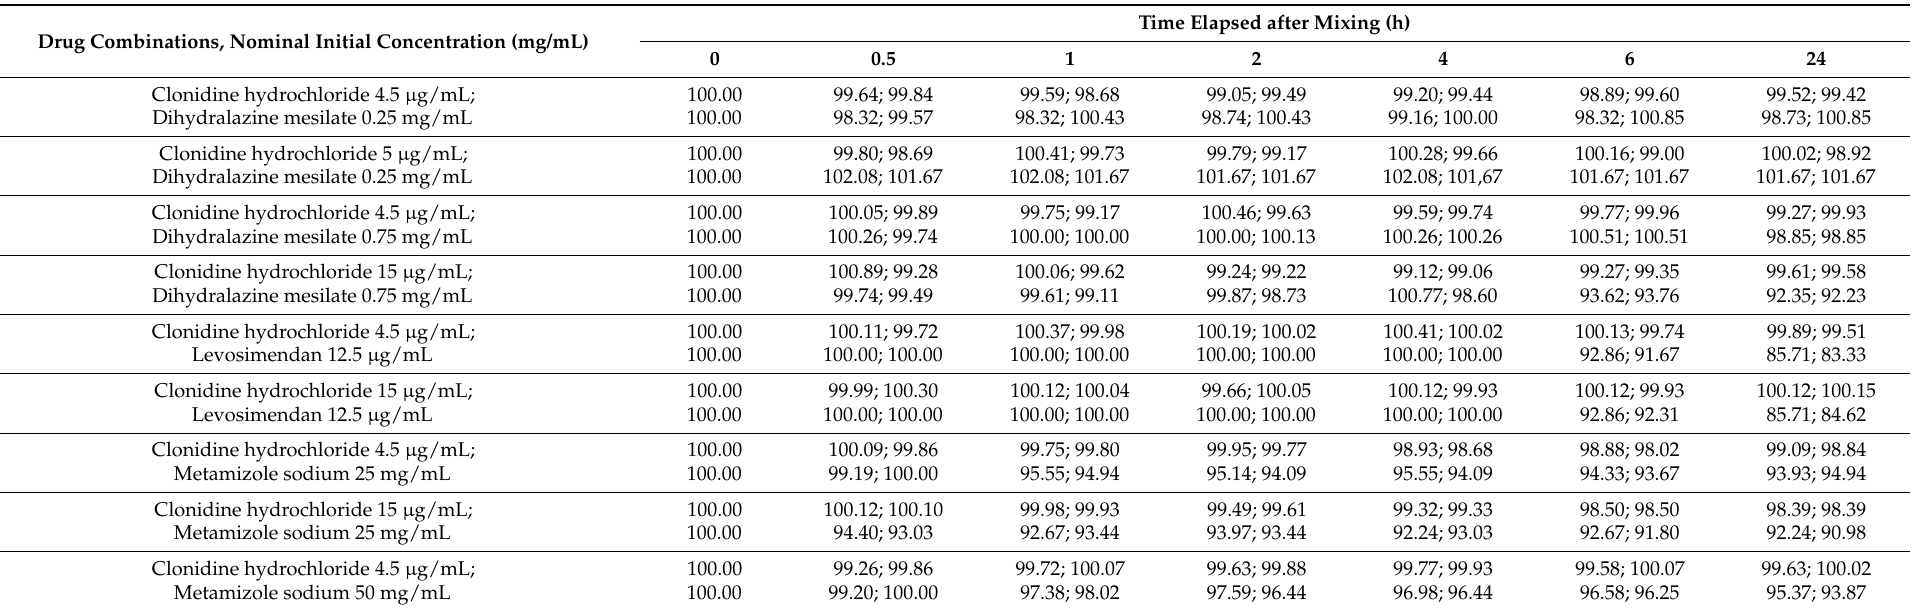
Table A5. Chemical compatibility of binary